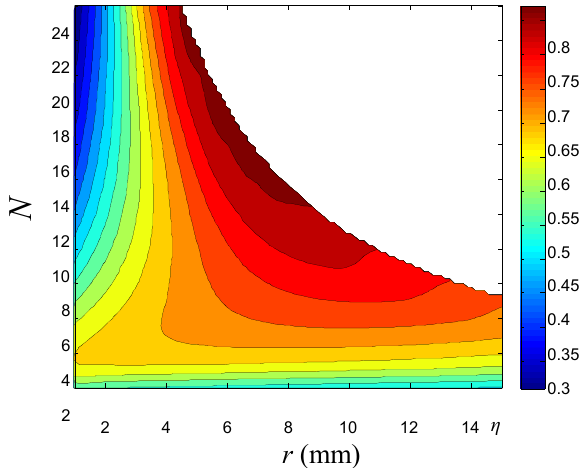
Figure 10. Output efficiency with variable N and r.